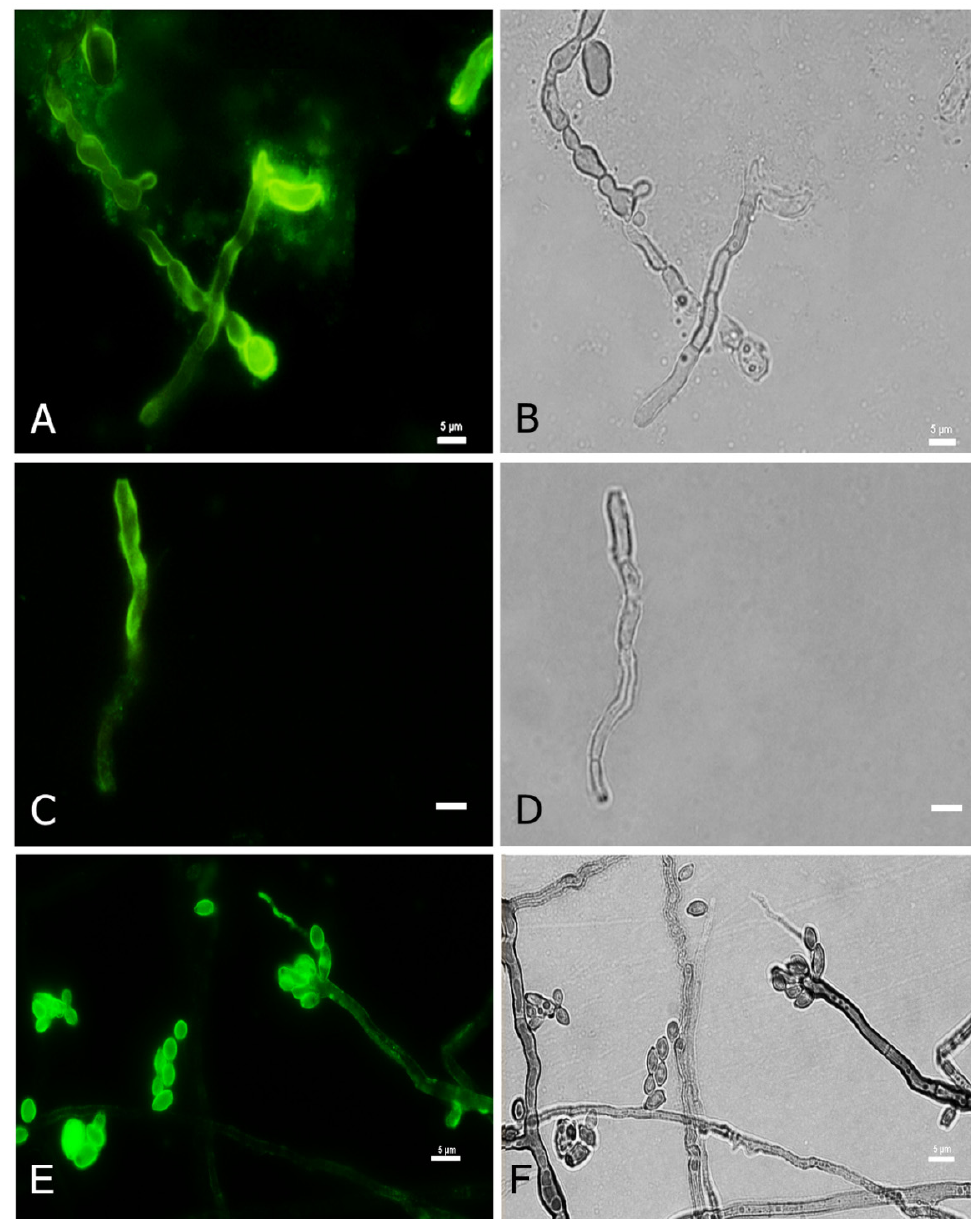
Figure 4. Melanin-specific MAb 8D6 labels the cell walls of septate hyphae of fungal keratitis caused by F. pedrosoi . Corresponding immunofluorescence and bright-field microscopy images demonstrating the labelling with MAb 8D6 of the cell walls of hyphae in a corneal sample of FK ( A , B ), melanin extracted particles of hyphae recovered from the patient’s corneal material ( C , D ) and melanin expression in the associated F . pedrosoi culture ( E , F ). Bars, 5 μ m.